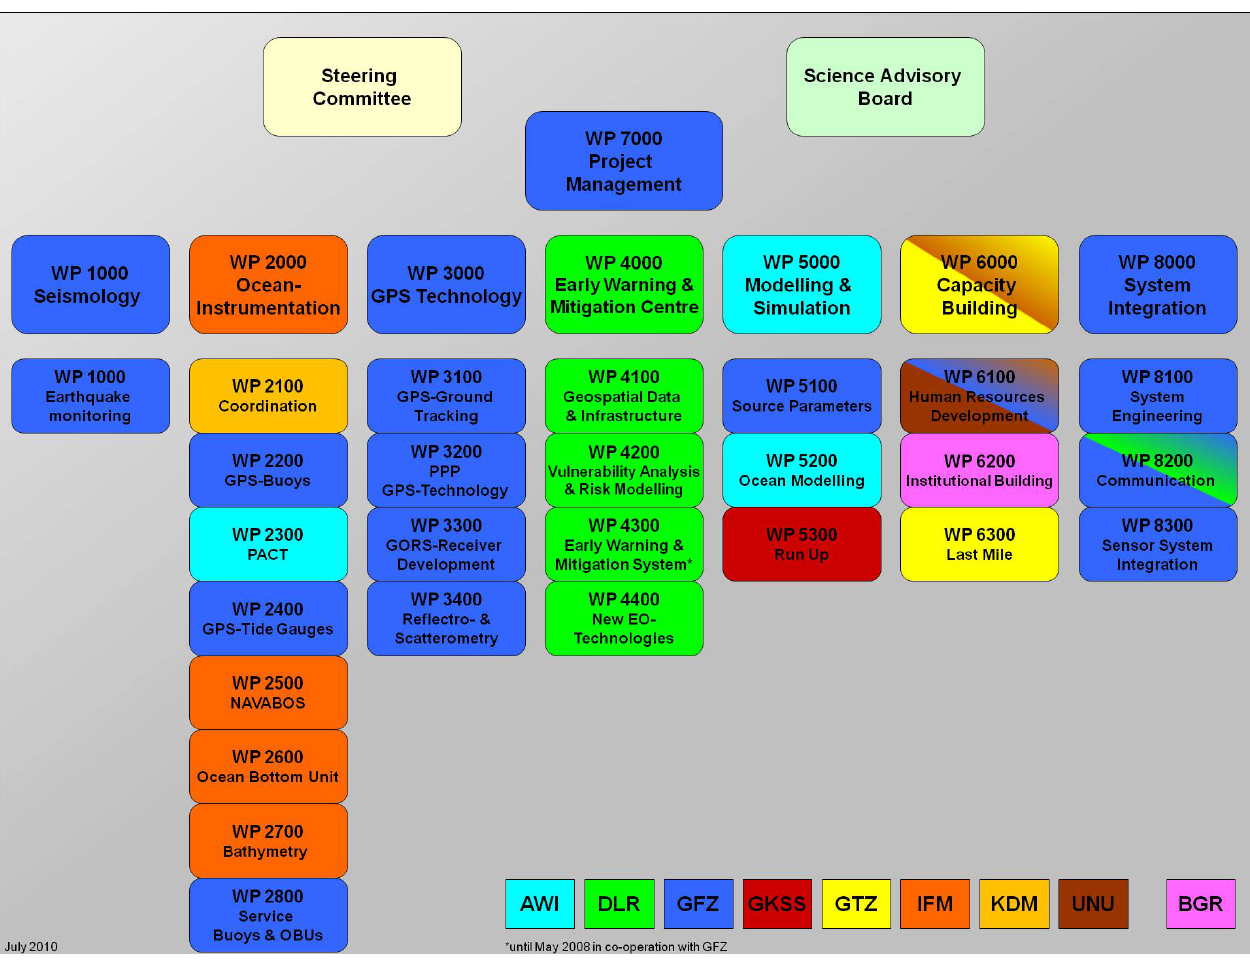
Fig. 1. Organisational chart of the GITEWS